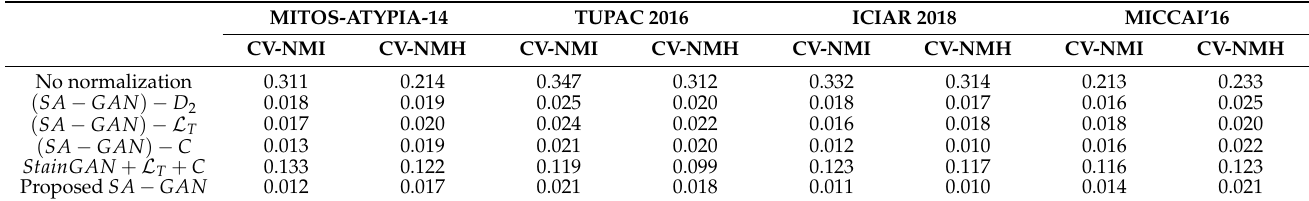
Table 4. CV-NMI and CV-NMH for different configurations of the SA-GAN model.